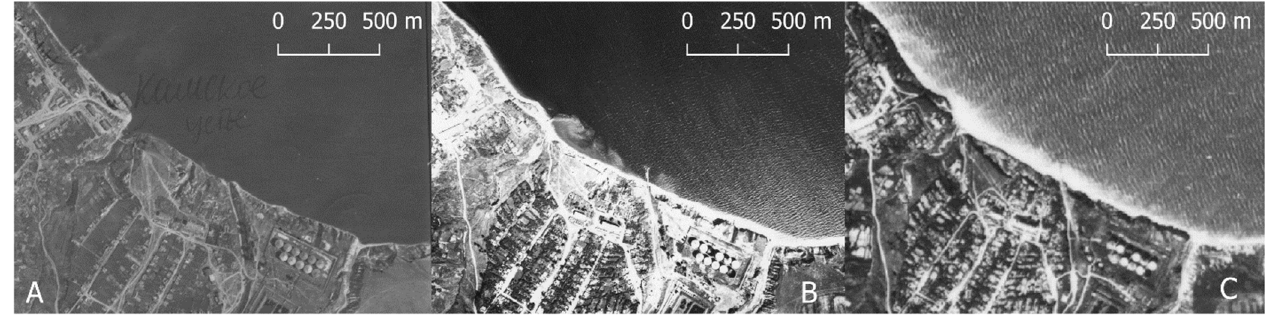
Figure 10. Site 2 depicted on the aerial images of 1958 ( A ), 1985 ( B ), and 1987 ( C ).